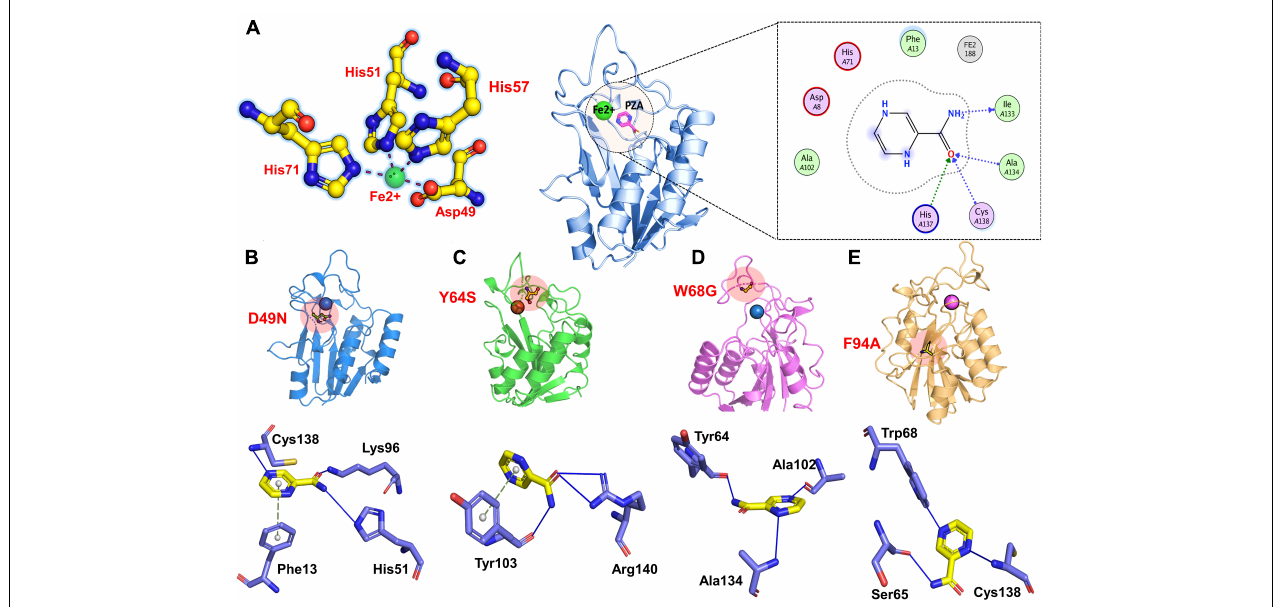
FIGURE 1 | 3D structure of the PZase along with the PZA drug and the Fe 2 + metal shown in the circle. The figure also shows the binding of Fe 2 + ion and PZA drug to the wild type (A) , D49N (B) , Y64S (C) , W68G (D) , and F94S (E)